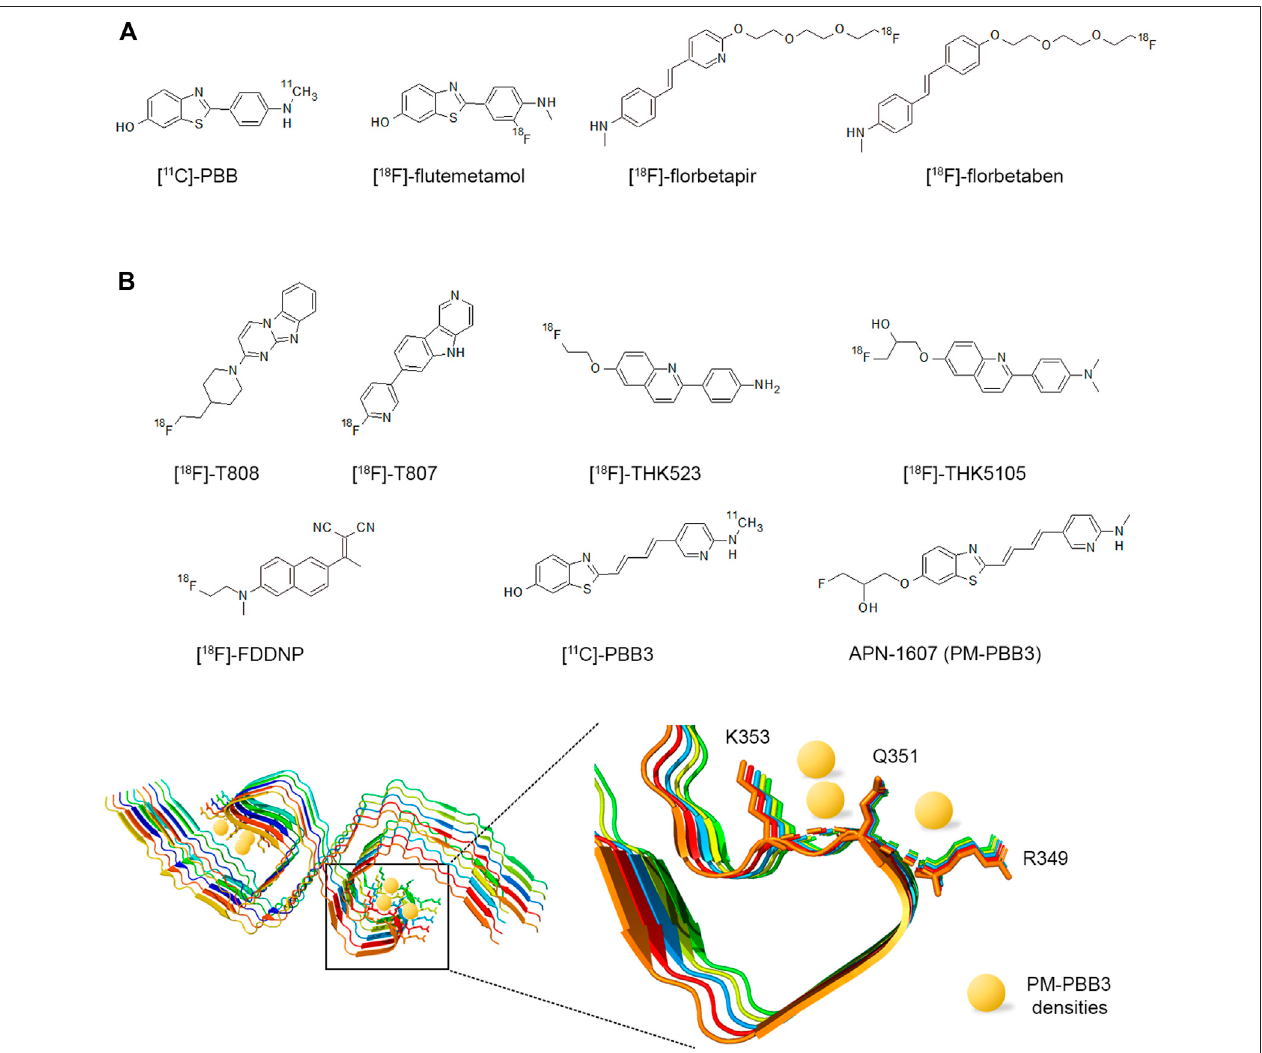
FIGURE 10 | Structures of PET radiotracers for amyloid imaging of A β deposits (A) or tau inclusions (B) . The cryo-EM structure of the PM-PBB3 (APN-1607) compound bound to PHF-tau amyloid structure shows selected interactions in the C-shaped cavities with R349, Q351 and K353 amino acids of the tau MTBR R4 repeats (PDB ID: